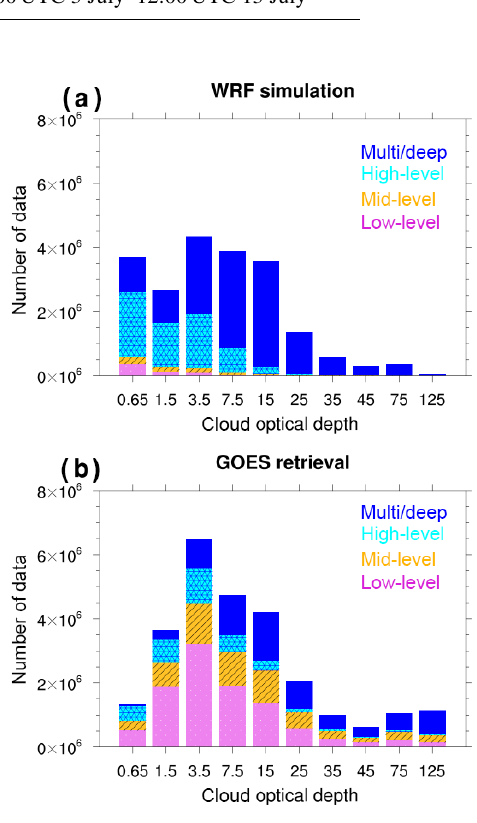
Figure 2. Histogram of hourly cloud optical depth (COD) during the daytime (16:00–23:00UTC) over the CONUS (land only) from the (a) WRF simulation (with the Morrison microphysics and the Grell 3-D schemes) and (b) GOES satellite retrievals. CODs on the x axis represent the mean values of the bins that are 0.3–1, 1–2, 2– 5, 5–10, 10–20, 20–30, 30–40, 40–50, 50–100, and 100–150. For a fair comparison, the multilayered WRF clouds are not resolved into cloud layers as this layering cannot be resolved by the